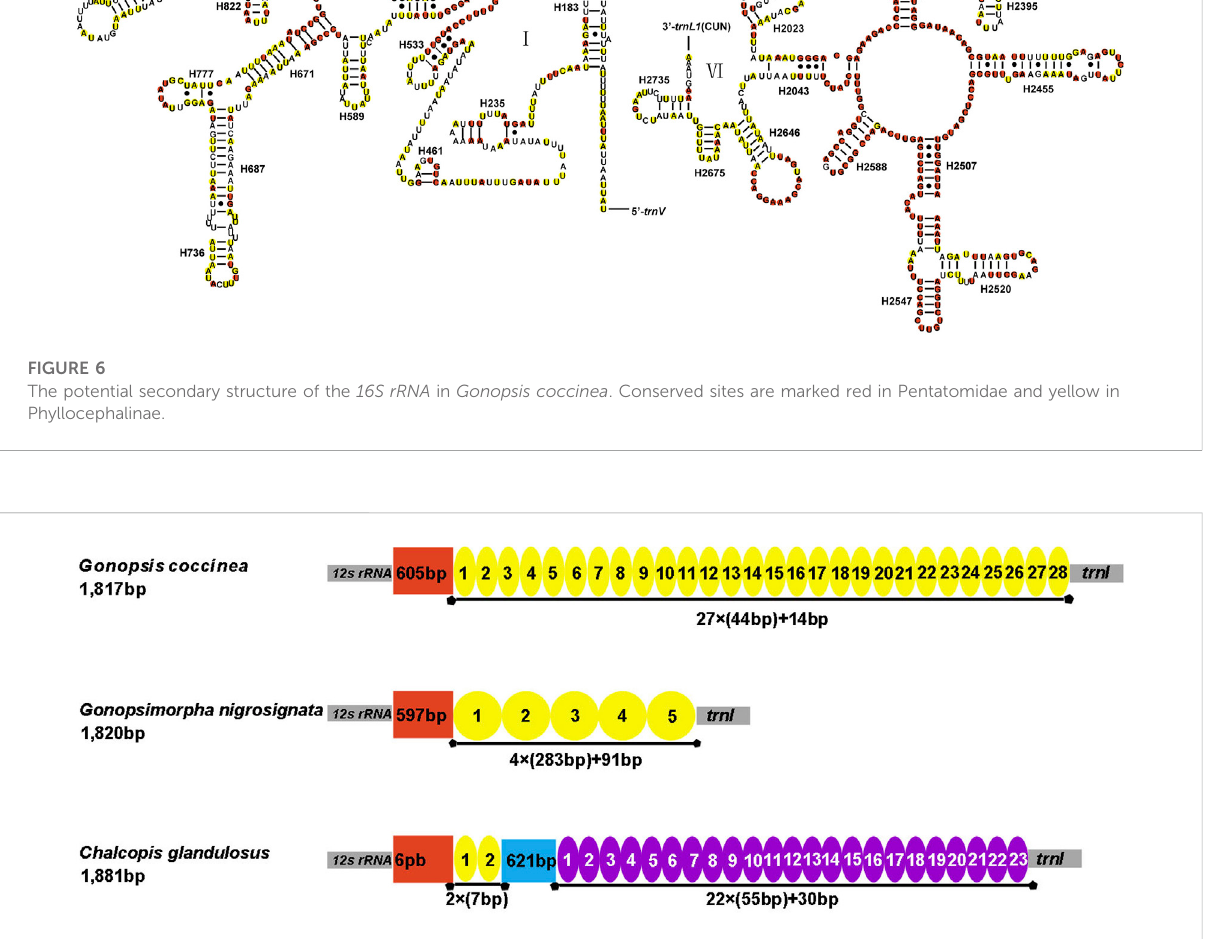
and trnI , with lengths of 1,817 bp ( Gonopsis coccinea ), 1,820 bp ( Gonopsimorpha nigrosignata ), and 1,881 bp ( C. glandulosus ), respectively. All three species showed extremely high A+ T contents of 85.25% ( Gonopsis coccinea ), 82.53% ( Gonopsimorpha